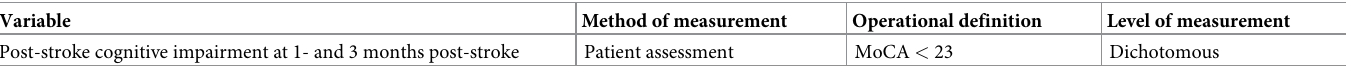
Table 1. Summary and description of objective number 1 variables of the study.